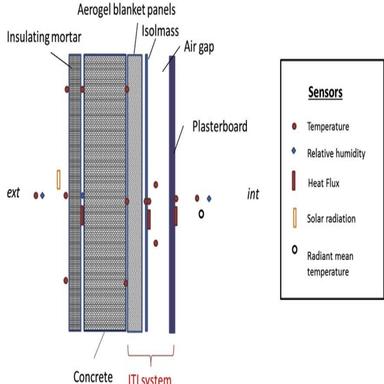
Cross section view of the test wall and location of the sensors.